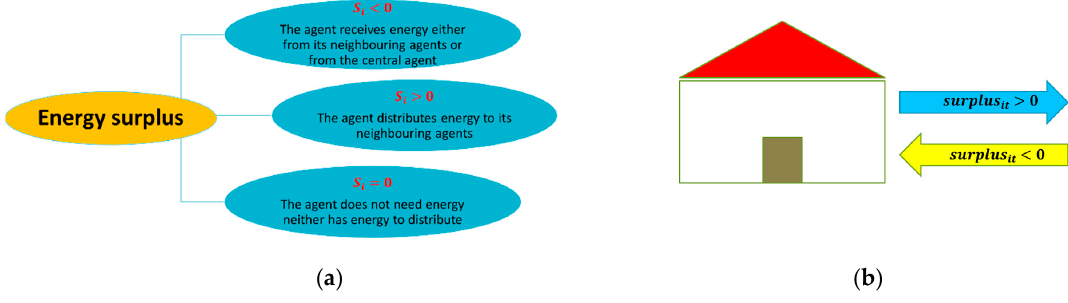
Figure 1. ( a ) Distribution patterns established on the grounds of the value of the surplus it ; ( b ) Direction of the energy exchange in accordance with the sign of the surplus it .